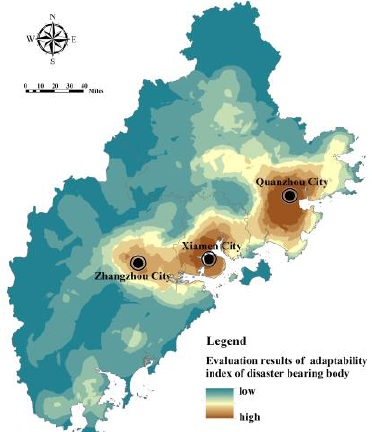
Figure 11. Assessment of the index of adaptability of disaster-bearing bodies in Fujian Delta.